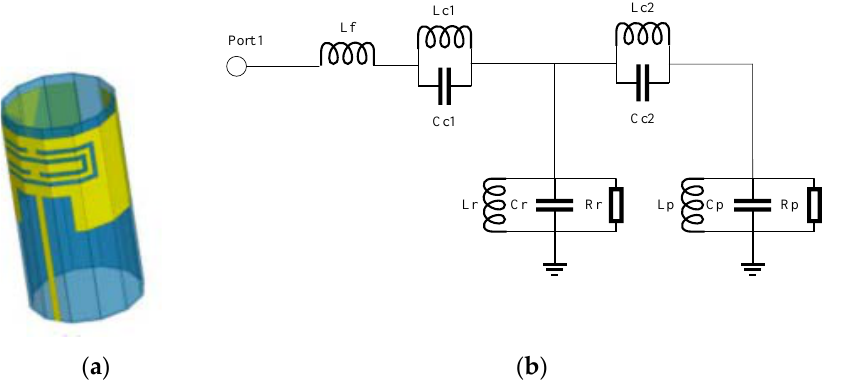
Figure 3. A compact omnidirectional self-packaged patch antenna with complementary split-ring resonator loading for wireless endoscope applications [77]. ( a ) The model of the package state of the antenna. ( b ) Equivalent circuit of the antenna.